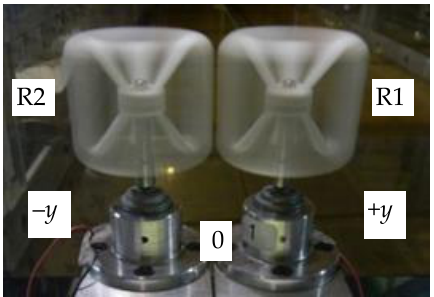
Figure 6. Experimental setup of a pair of 3-D-printed VAWT models with an extremely narrow gap of g / D = 0.1 (viewed from downstream).